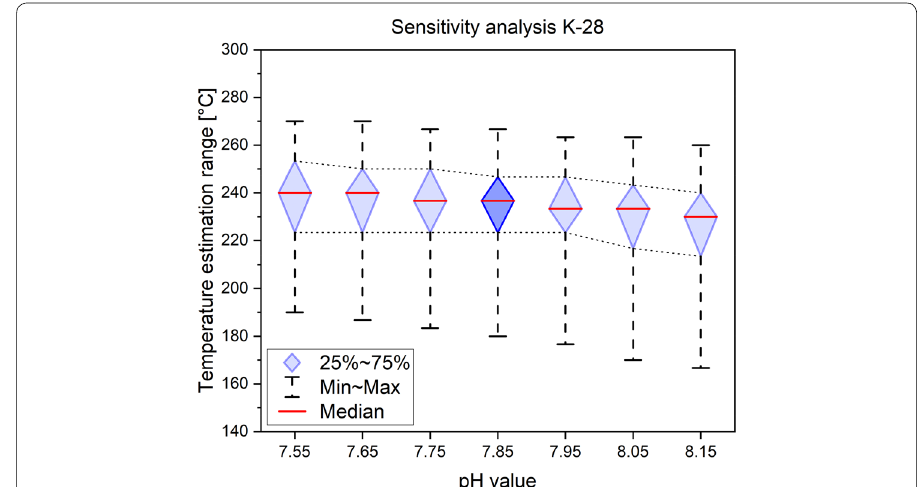
Fig. 3 Sensitivity analysis of pH for sample K-28. The value was varied from 6.75 to 8.15 in increments of 0.1. The figure shows an extract of the data, where the pH value ranges from 7.55 to 8.15 in increments of 0.1. For pH 7.85, the statistical minimum of the boxplot comparison is reached; it is highlighted in a darker blue